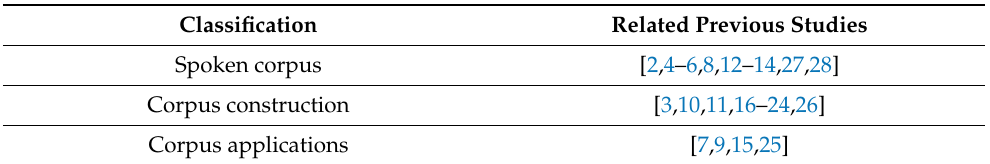
Table 1. Summary of related previous